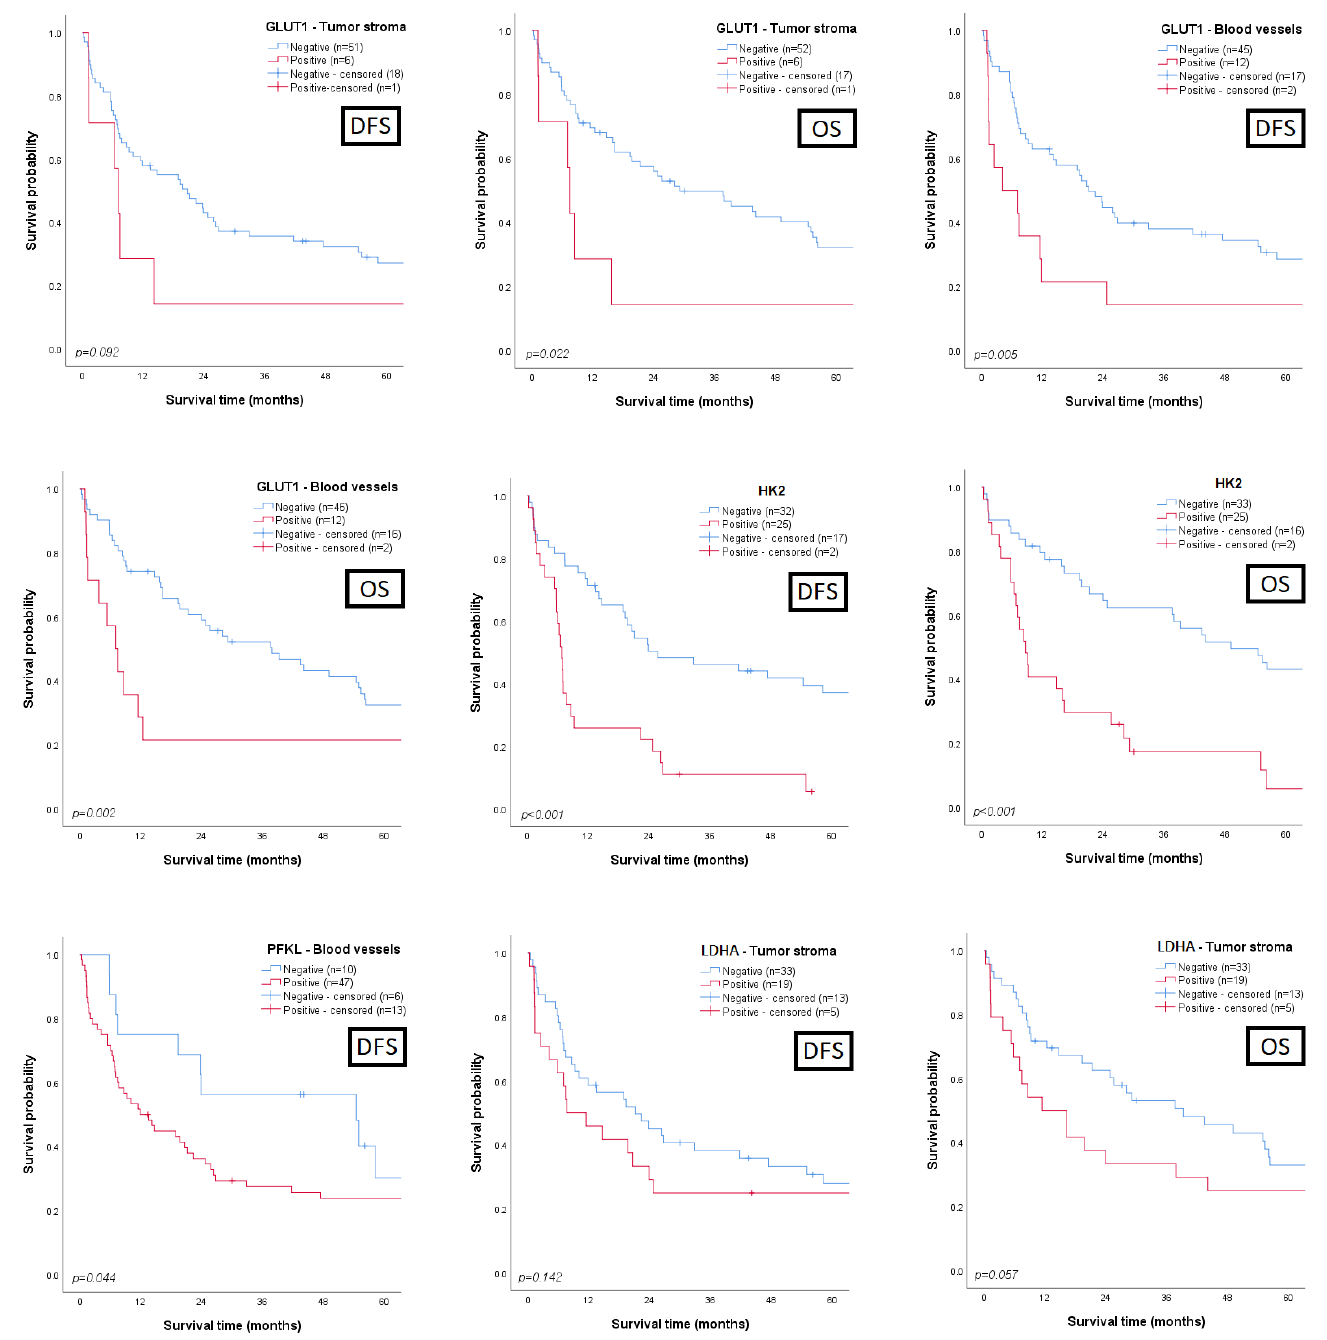
Figure 2. Kaplan–Meier curves demonstrating disease-free (DFS) and overall survival (OS) of patients with urothelial bladder carcinoma, based on GLUT1 (n = 76), HK2 (n = 76), PFKL (n = 76), and LDHA (n = 70) immunoexpression status in the tumour stroma (GLUT1 and LDHA), in the intratumoural blood vessels (GLUT1 and PFKL) and in the global tissue sections (HK2). p values from log-rank or Breslow tests.